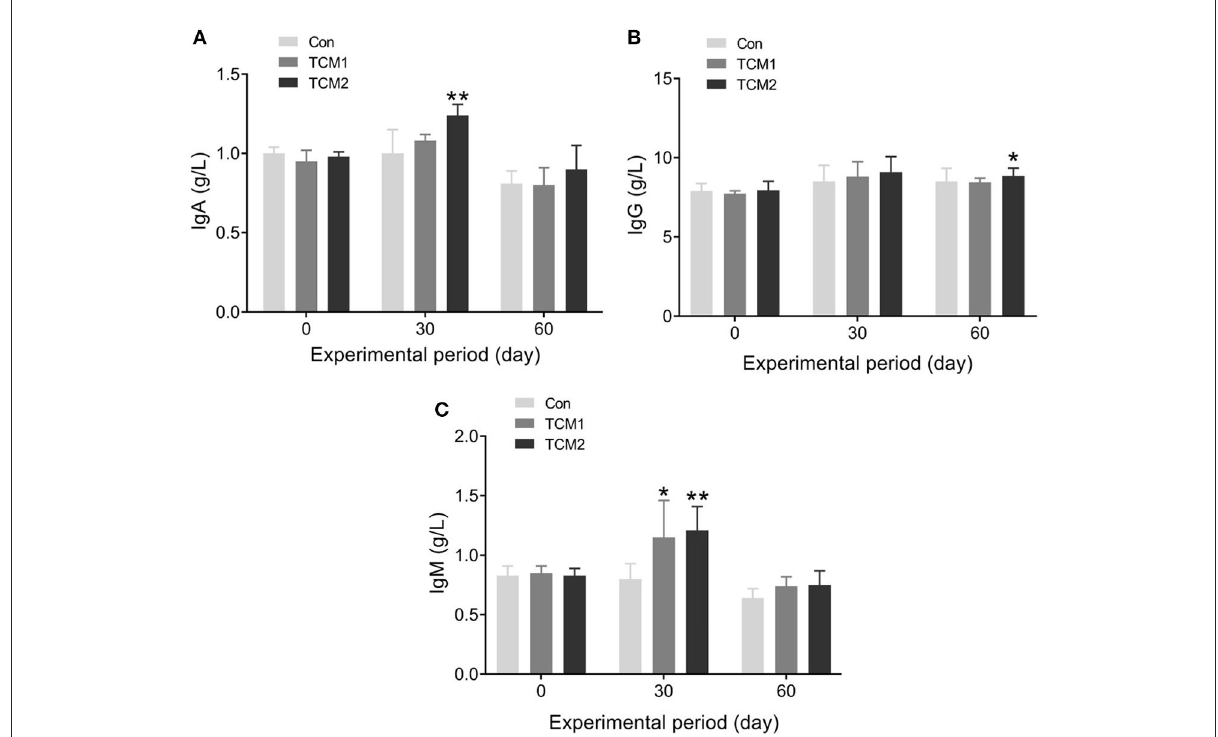
FIGURE1 Effect of TCM1 and TCM2 on serums IgA, IgG, and IgM in finishing swine. “*” indicates significant difference compared with the control group (* P < 0.05, ** P < 0.01). Below is the same. (A) IgA level. (B) IgG level. (C) IgM level.